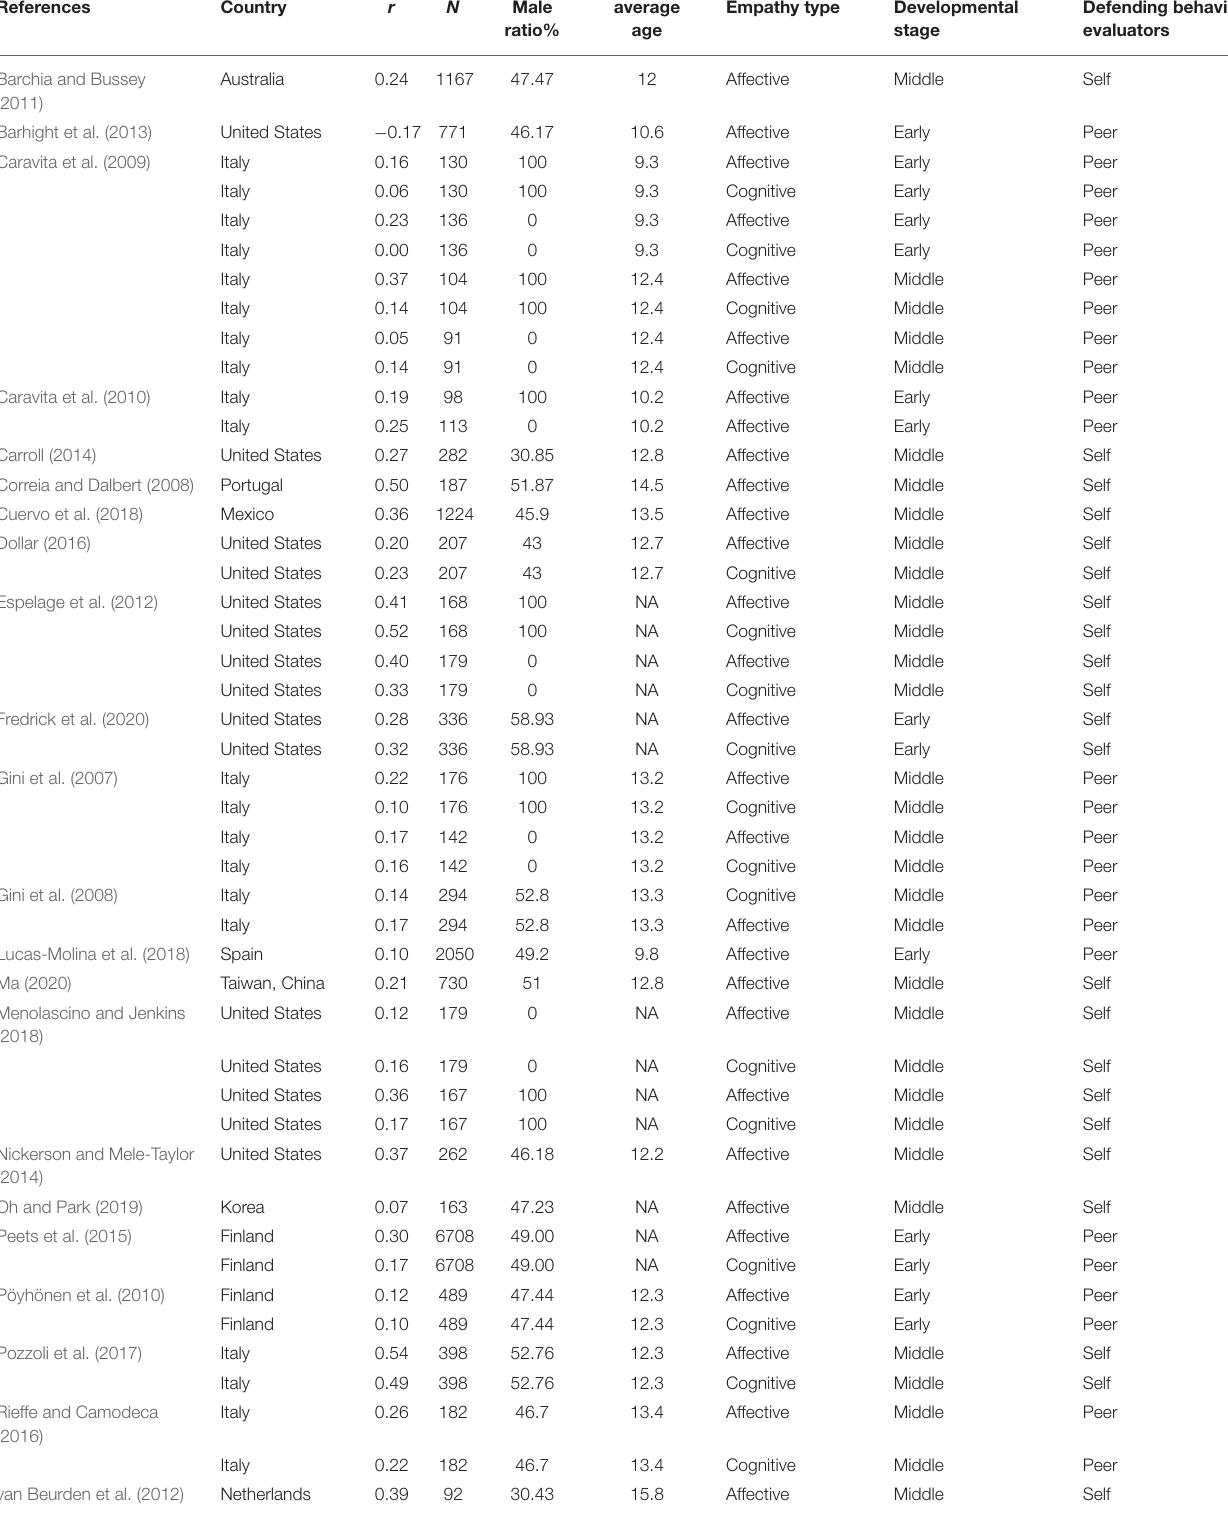
TABLE 1 | Studies included in the